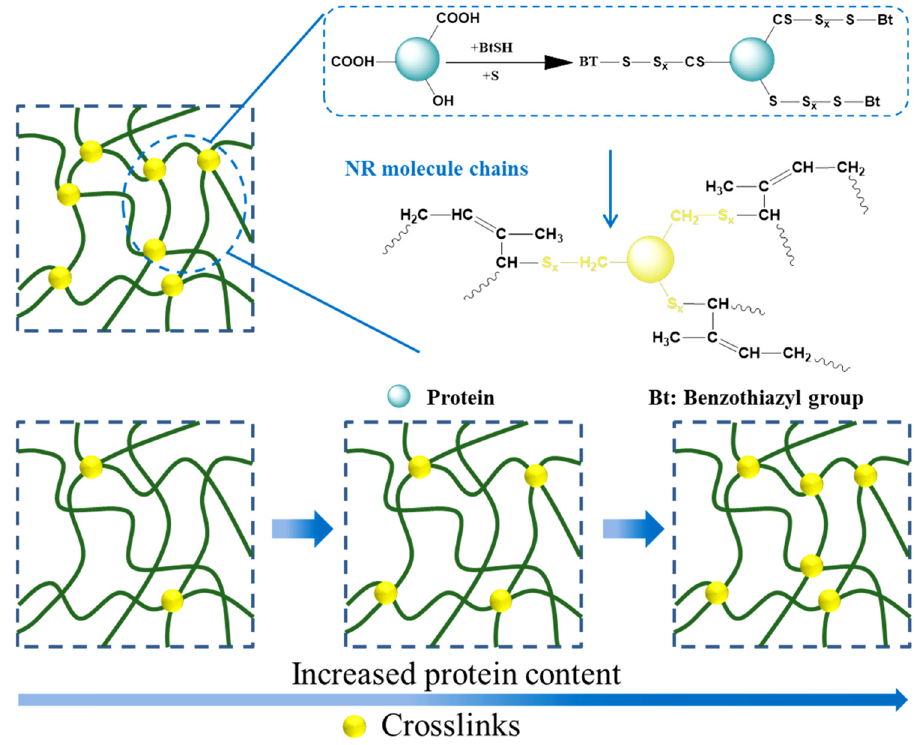
Figure 5: Schematic diagram of protein accelerating vulcanization